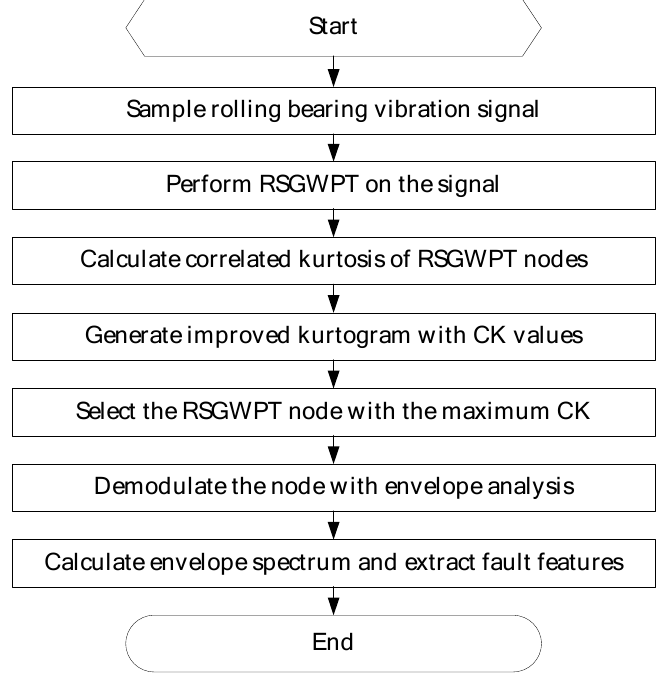
Figure 4. Flow chart of the proposed method.